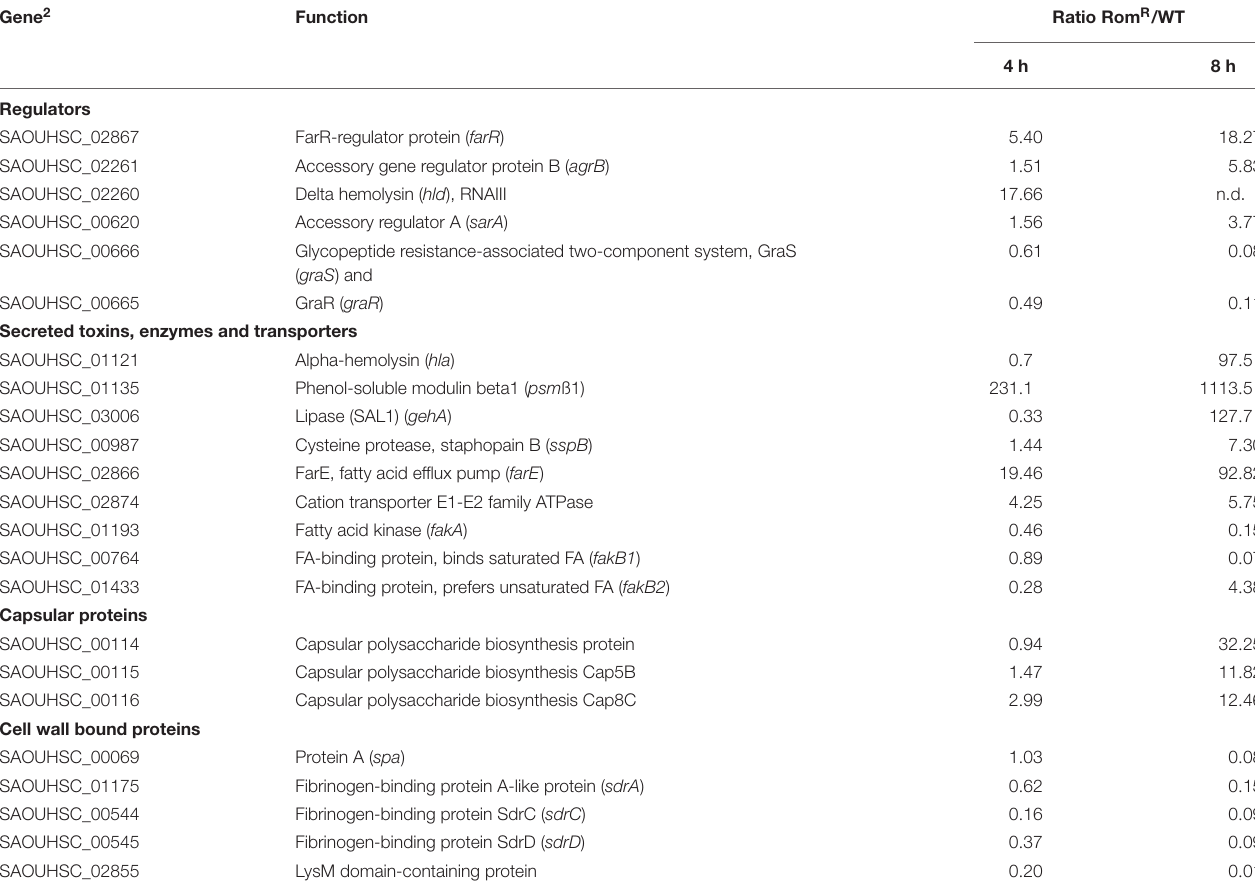
TABLE 3 | Selected annotated genes that are up- or down-regulated in Rom R clone 1 . Gene 2